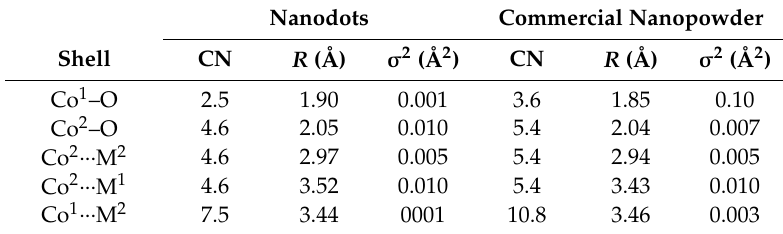
Figure 6. X-ray absorption fine structure spectroscopy (EXAF) signals at ( a ) Co K-edge and ( b ) Fe K-edge. The corresponding Fourier transform magnitudes (FT magnitudes) at ( c ) Co K-edge and ( d ) Fe K-edge for samples at different preparation stages. All plots share the same sample sequence and color code. The solid red lines are the simulation results. The four dashed vertical lines in ( b ) and ( d ) are used to label the typical peak positions for different shells (see text). Table 3. Two-body simulation results at Co K-edge of the CFO standard and the nanodots annealed at 600 ◦ C and then 950 ◦ C, where CN is the coordination number, R is the atomic distance, and σ is the Debye–Waller factor indicating the static and thermal disorder of the